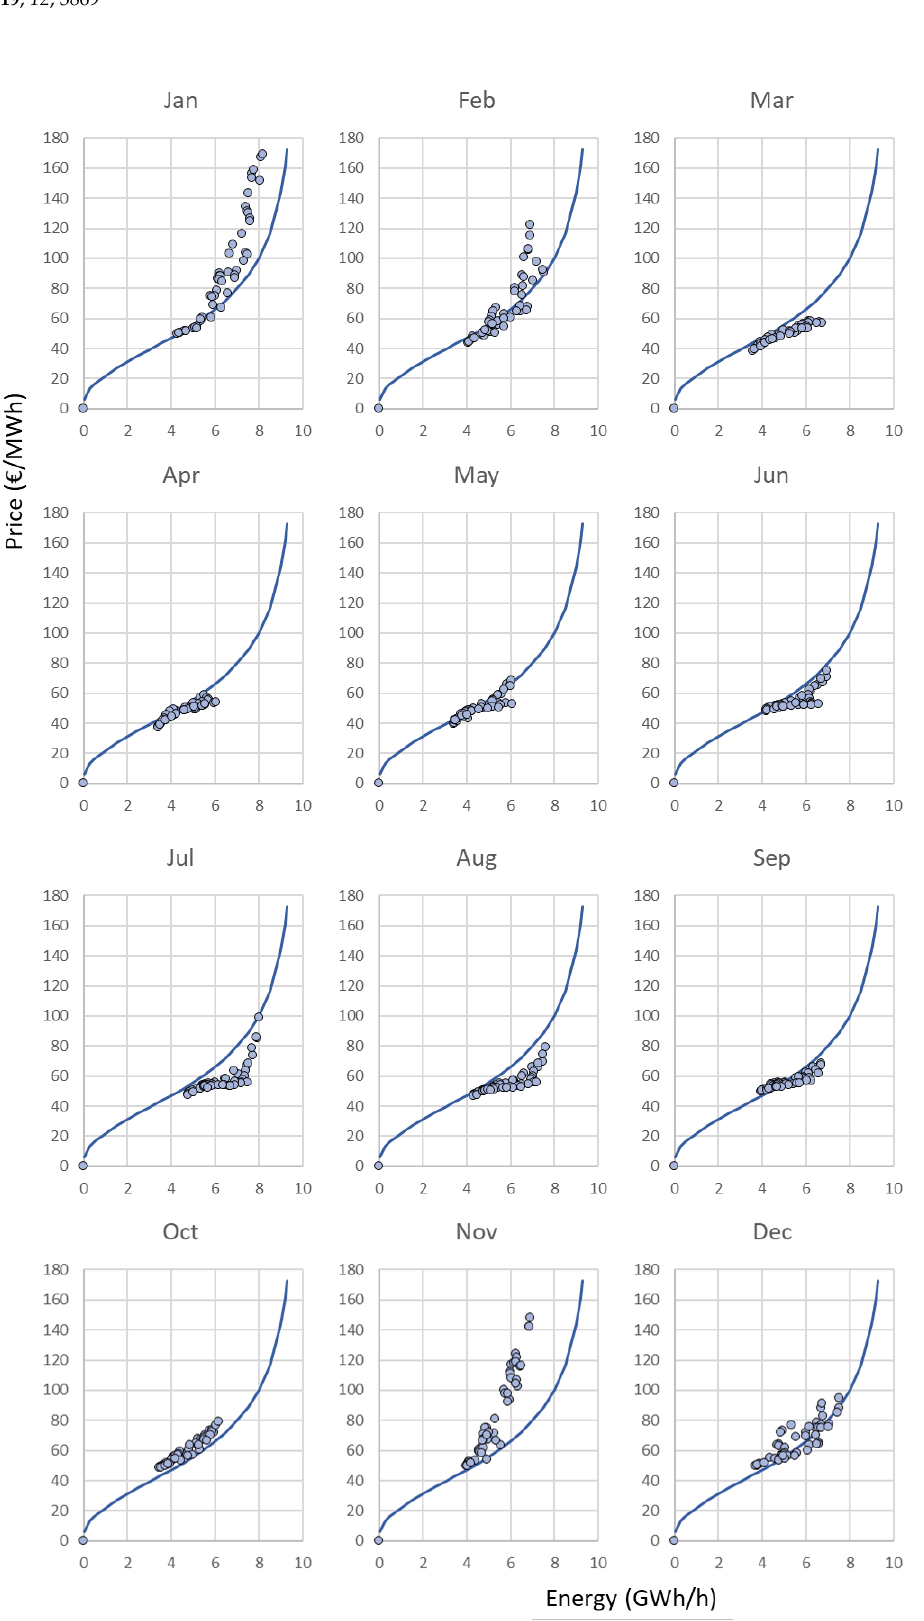
Figure 11. Merit order curve: Comparison between real and model calculated values. Monthly averaged values.